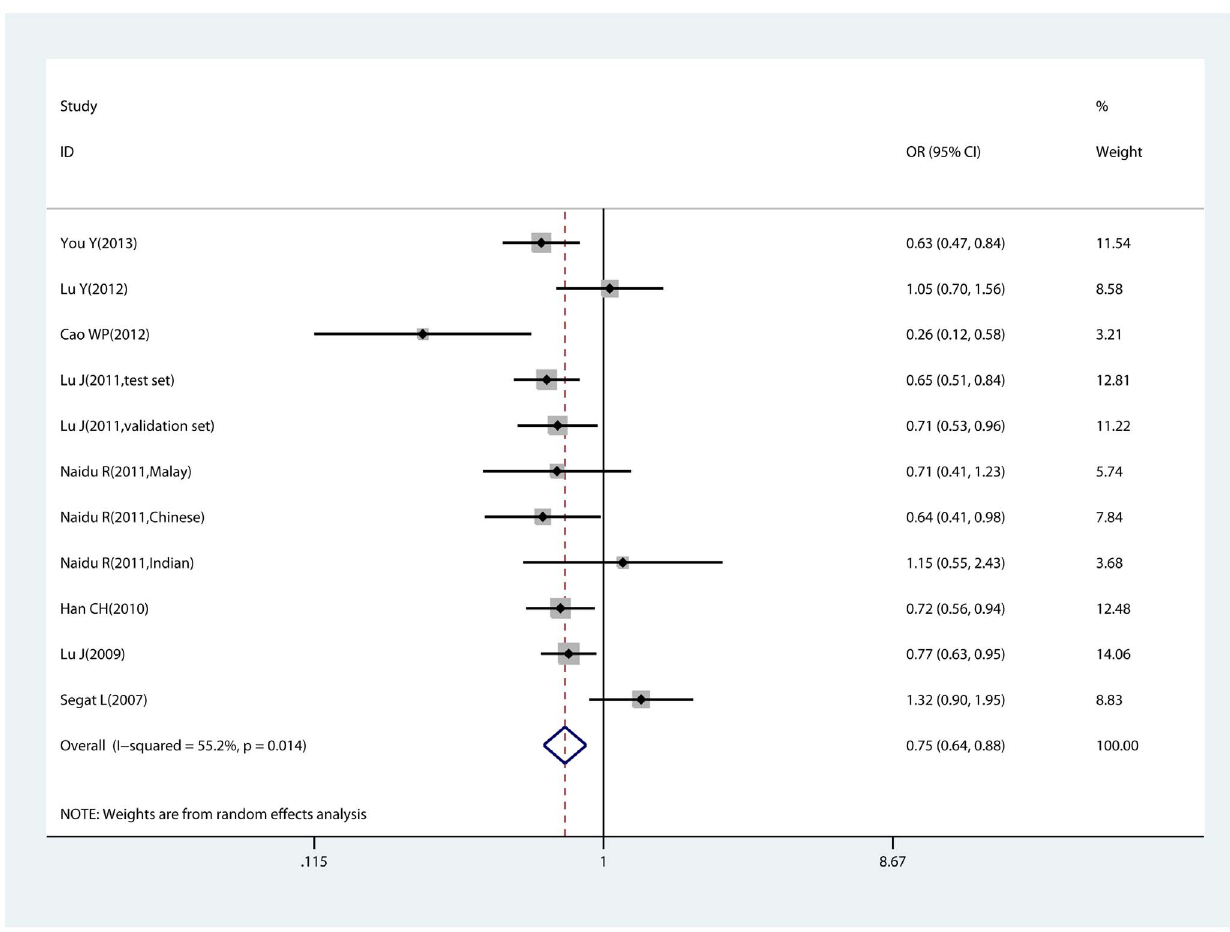
Figure 2. Forest plot of allele comparison (C vs. G estimated by genotype distribution data. Allele comparison calculated with random- effects model. Odds ratio=0.750, 95% confidence intervals: 0.639–0.880.